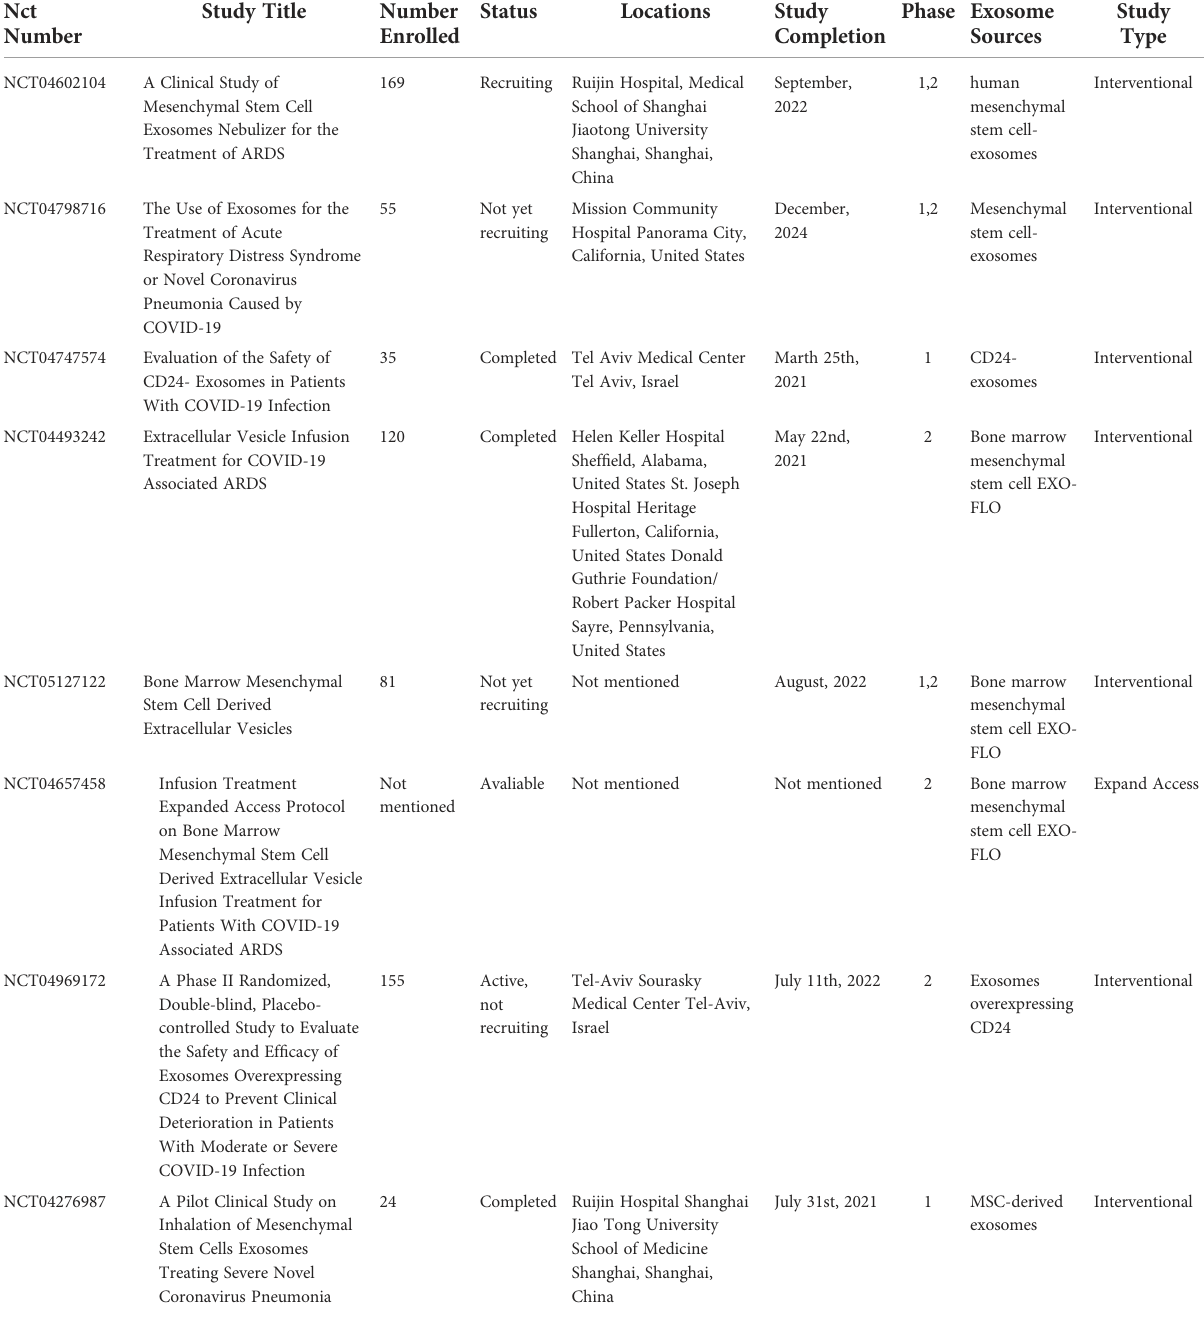
TABLE 1 Summary of clinical trials involving exosomes in ALI/ARDS